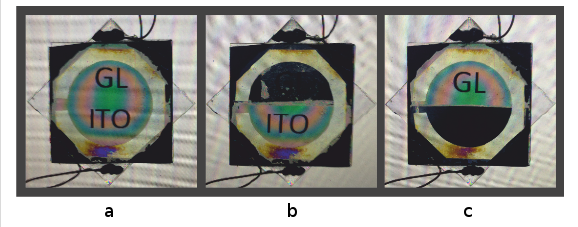
Figure 2: Images of the graphene–ITO hybrid liquid crystal (LC) cell between crossed polarizers: voltage not applied (a), peak-to-peak voltage V pp = 40 V applied to LC cell with graphene electrodes (b), and with ITO electrodes